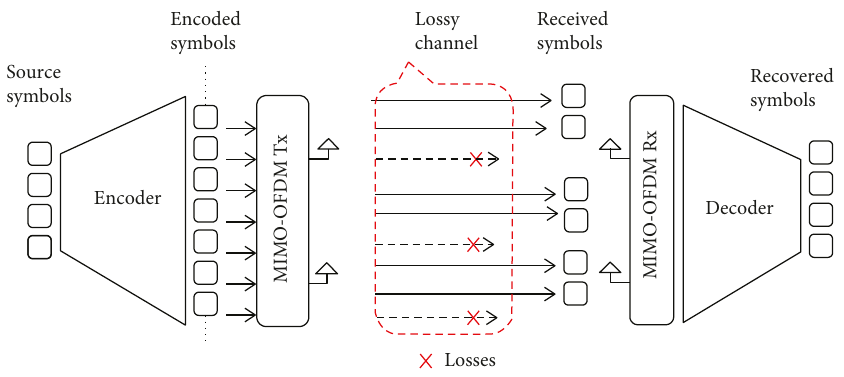
Figure 2: A rateless encoder and decoder in a lossy MIMO